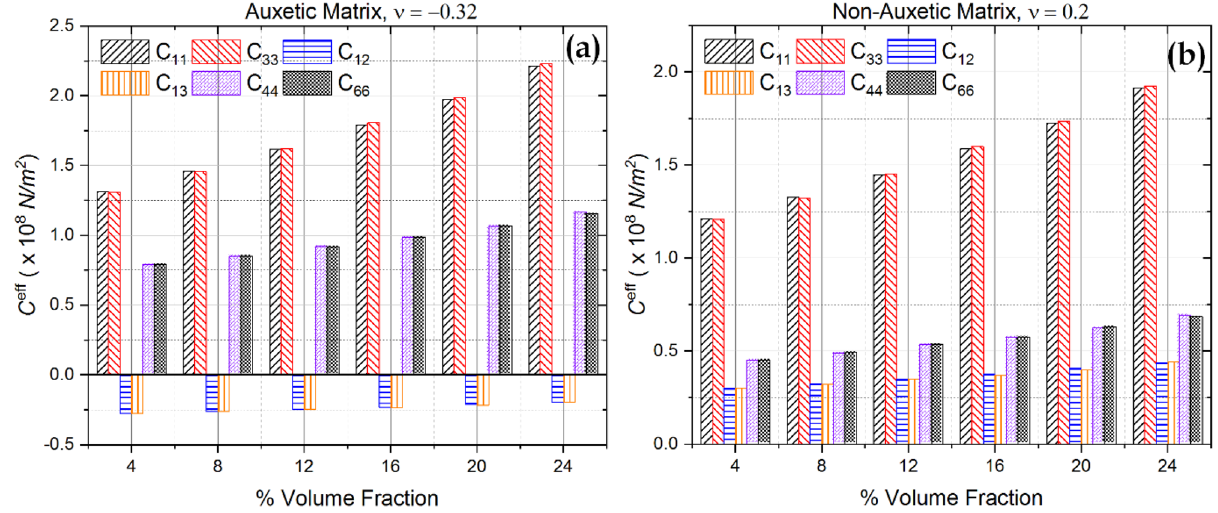
Figure 6. Effective stiffness parameters calculated at different volume fractions ( a ) Auxetic matrix ( b ) non- Auxetic Matrix.